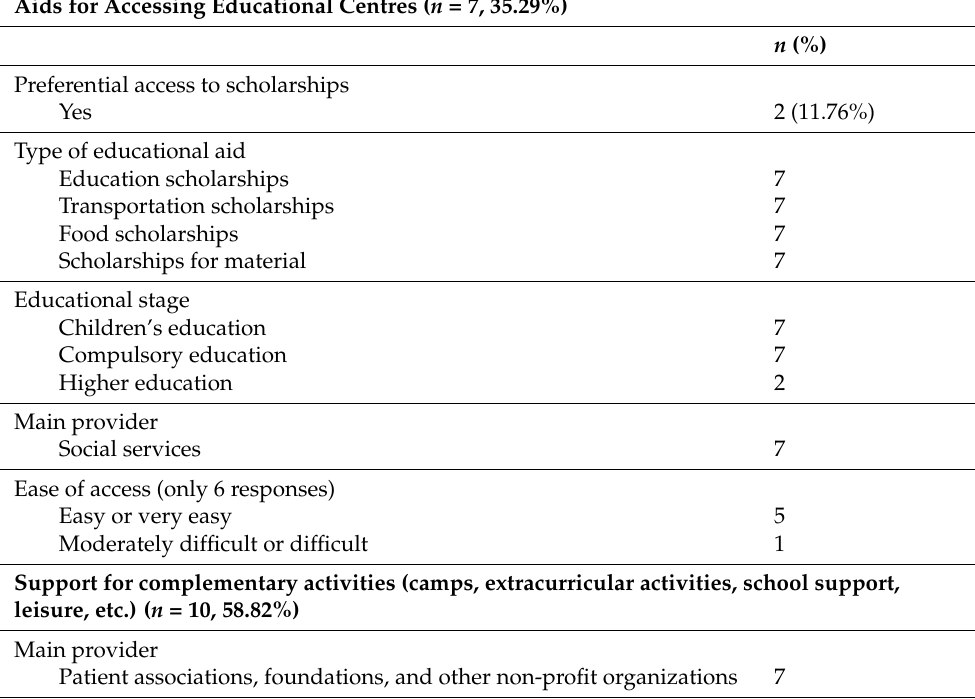
Table 3. Accessibility to long-term financial assistance. n = number of centres where it is available. In bold, main questions.